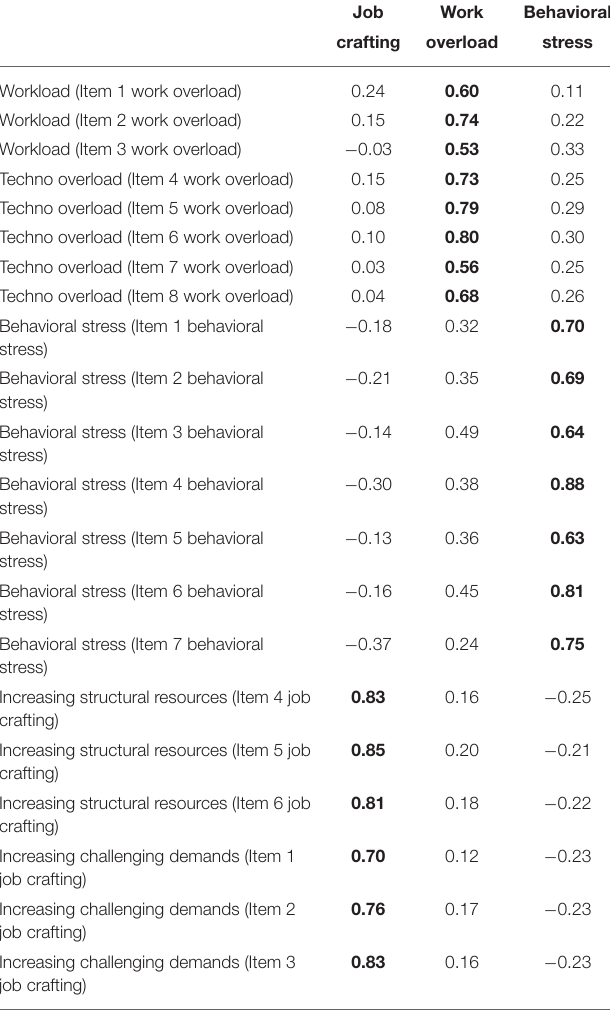
TABLE 2 | Cross-loadings of manifest variables (discriminant